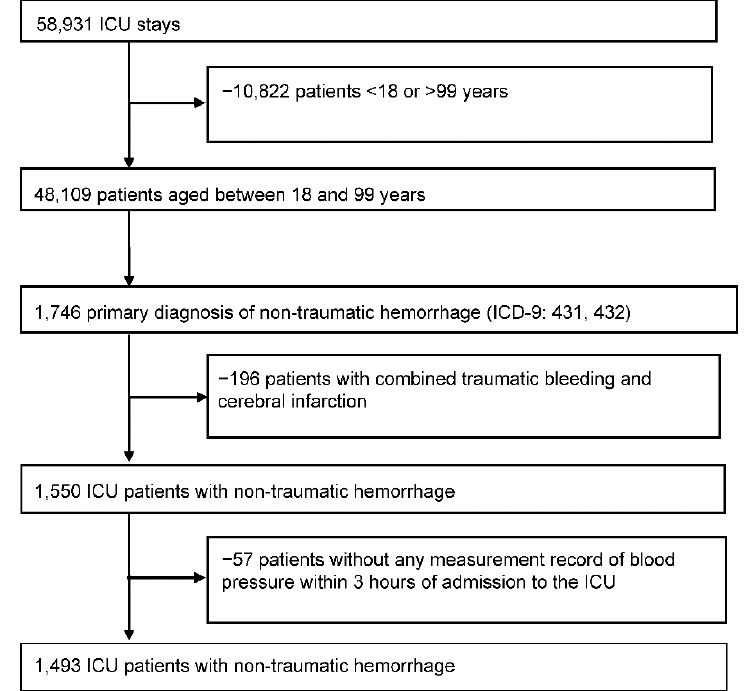
Figure 1. Screening of patients for ICU stays with a record of intracerebral hemorrhage (ICH) analysis. ICD-9-CM, International Classification of Diseases, 9th Revision, Clinical Modification; ICU, intensive care unit; ICH, intracerebral hemorrhage.